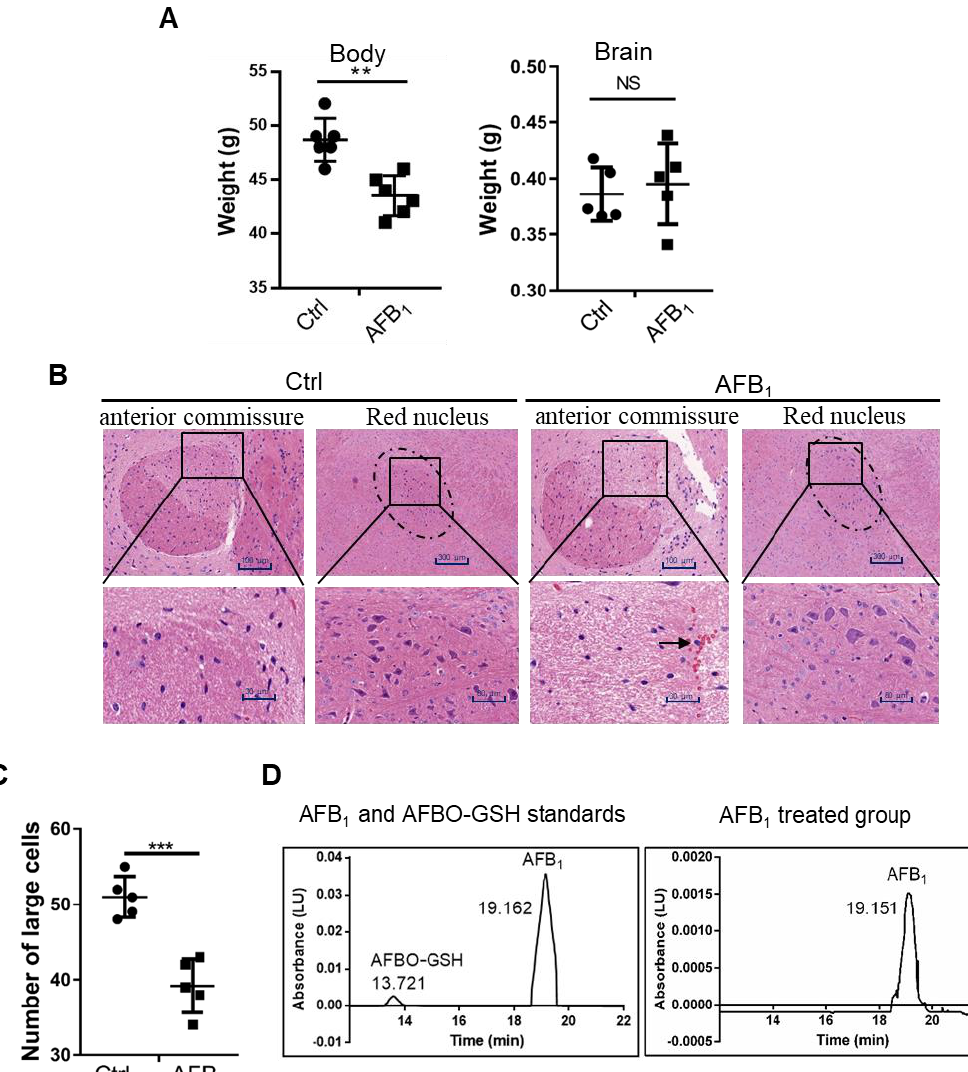
Figure 1. AFB 1 enters the brain and causes brain damage after 30 days of dietary administration (300 µ g / kg). ( A ) Body weight and brain weight. ( B ) Haematoxylin and eosin (HE) staining of brain histopathological sections. The edge between the anterior commissure and surrounding organisations is indicated as a square and enlarged. The dashed circle indicates red nucleus. The black arrow indicates red-cell infiltration. ( C ) The number of large cells in the red nucleus in panel B was counted. ( D ) HPLC analysis of the content of AFB 1 in mouse brains. All experiments were performed in triplicate and the values represent the mean ± SD of three independent experiments. Statistical significance was defined as ** p < 0.01, or *** p < 0.001.